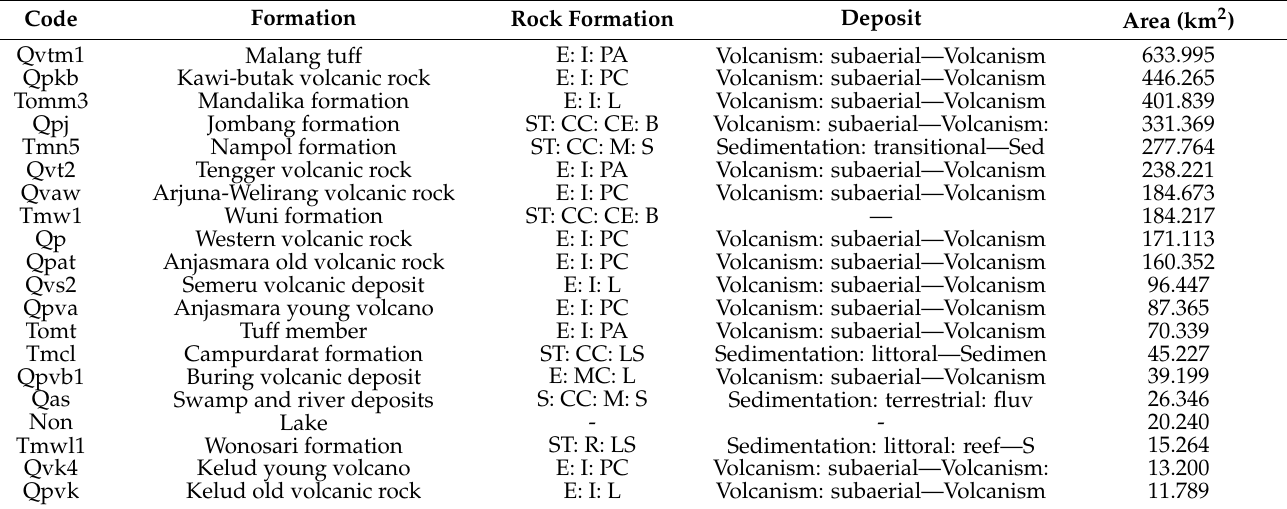
Table 1. Geological unit, Malang